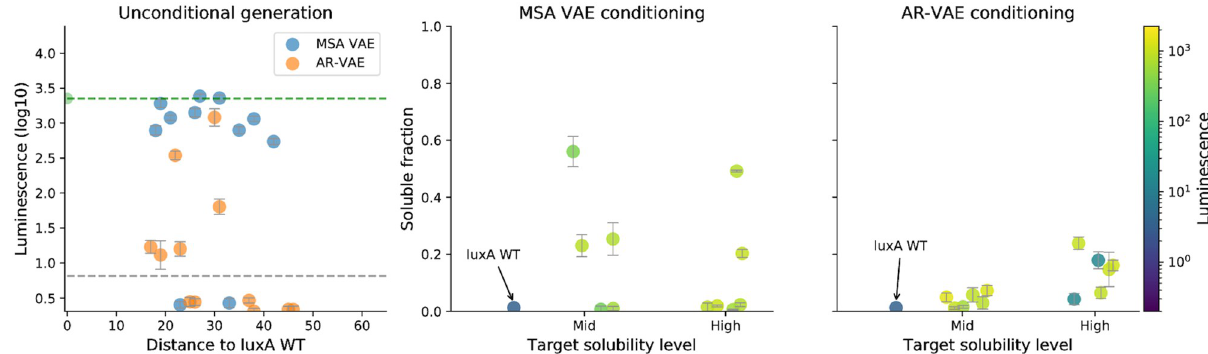
Fig 6. Luminescence measurements for synthesised protein sequences generated from latent vectors sampled from the neighbourhood of the encoding of the P. luminescens luxA sequence. Left: luminescence of sequences generated by VAE models trained on raw (AR-VAE) or aligned (MSA VAE) sequences from the family of luciferase-like proteins (mean across fifteen replicates, error bars represent standard deviation). Wild-type sequence luminescence is displayed as a dashed green line. The dashed grey line represents the detection threshold, conservatively set to twice the mean untransformed luminescence of a strain lacking luxA . Distance is computed as number of substitutions and indels relative to wild type. The MSA VAE model was able to generate functional sequences with large numbers of differences to wild type, whereas the AR-VAE model seemed to introduce deleterious mutations more rapidly. Center and right: measurements of both solubility and luminescence for sequences generated by VAE models conditioned on predicted solubility level show that conditional models can be used to engineer increased-solubility variants of a luxA sequence while preserving function. Solubility is reported as the ratio of the amount of protein present in the supernatant to the total amount in both supernatant and pellet of lysed E. coli cells over-expressing the protein, as measured by a dot blot assay (mean of four technical replicates, error bars represent standard